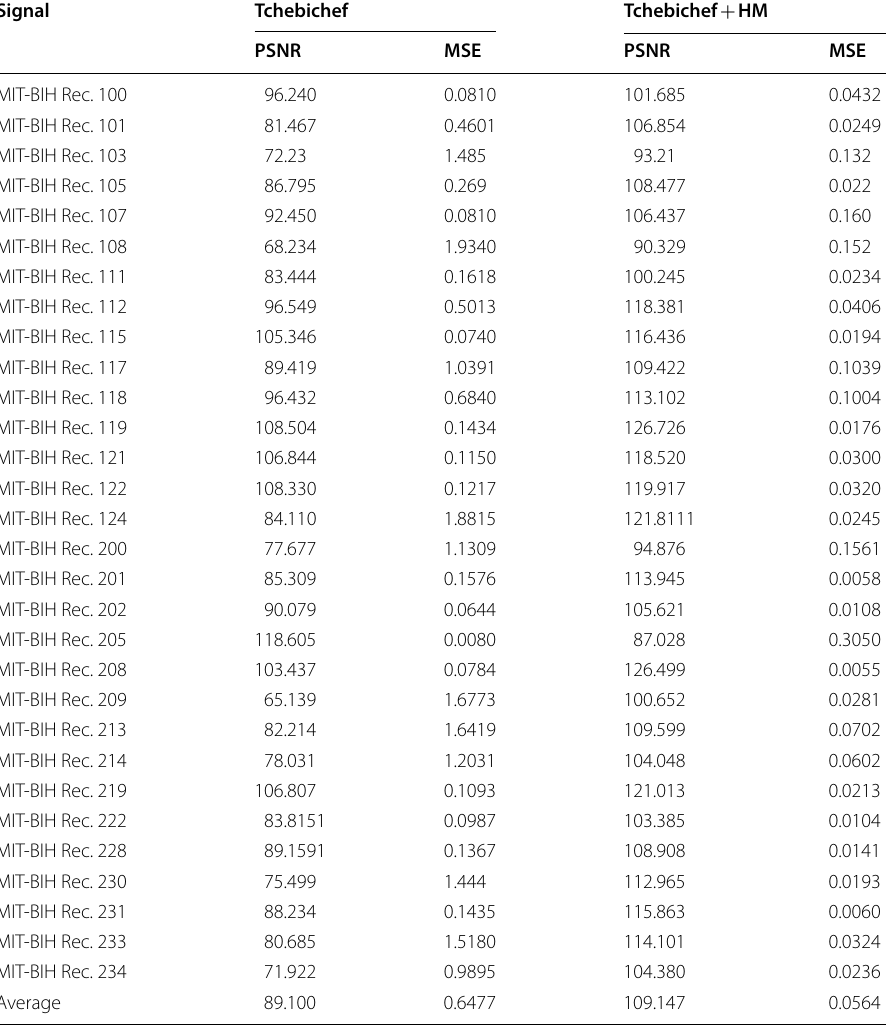
Table 2 Comparison of reconstruction errors (PSNR and MSE) using Tchebichef moments with and without Householder method Signal